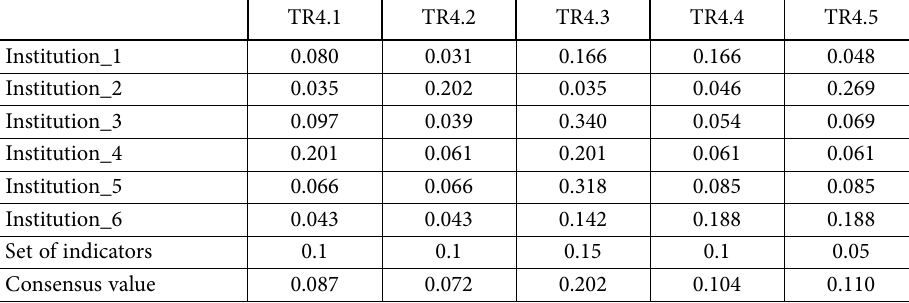
Table 6. Transparency-indicator weighting. Budgeting and economic information disclosure block